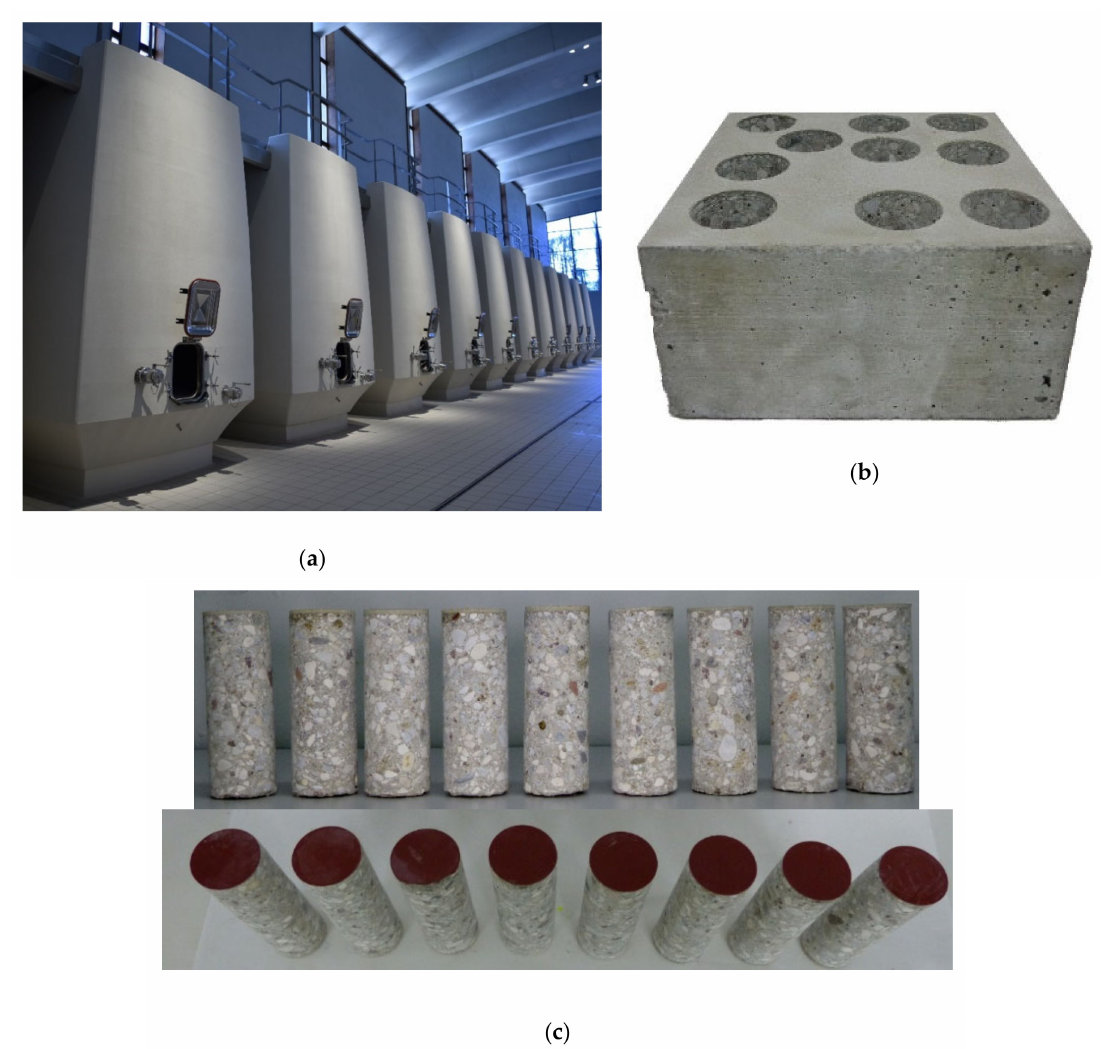
Figure 6. View of ( a ) concrete tanks manufactured with the analyzed concrete (Bodegas Ram ó n Bilbao, SPAIN), ( b ) view of a concrete block, and ( c ) samples selected for analysis and other similar pieces, but treated with epoxy on the